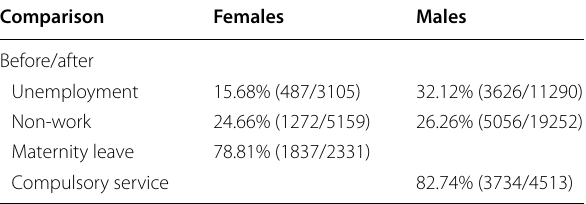
Table 4 Percentage employed with the same firm as before the period of absence from work, by